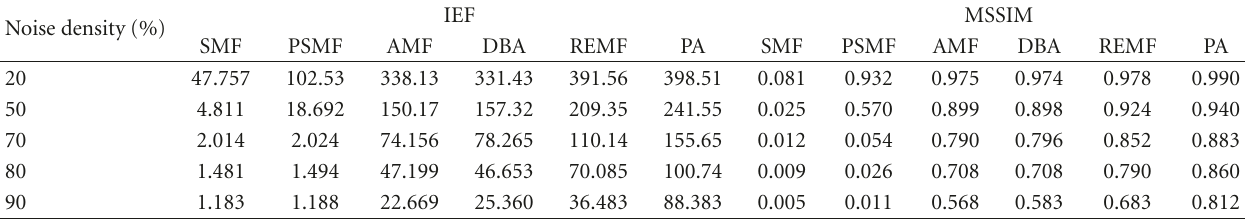
Table 2: IEF and MSSIM for various filters for Lena image at di ff erent noise densities.